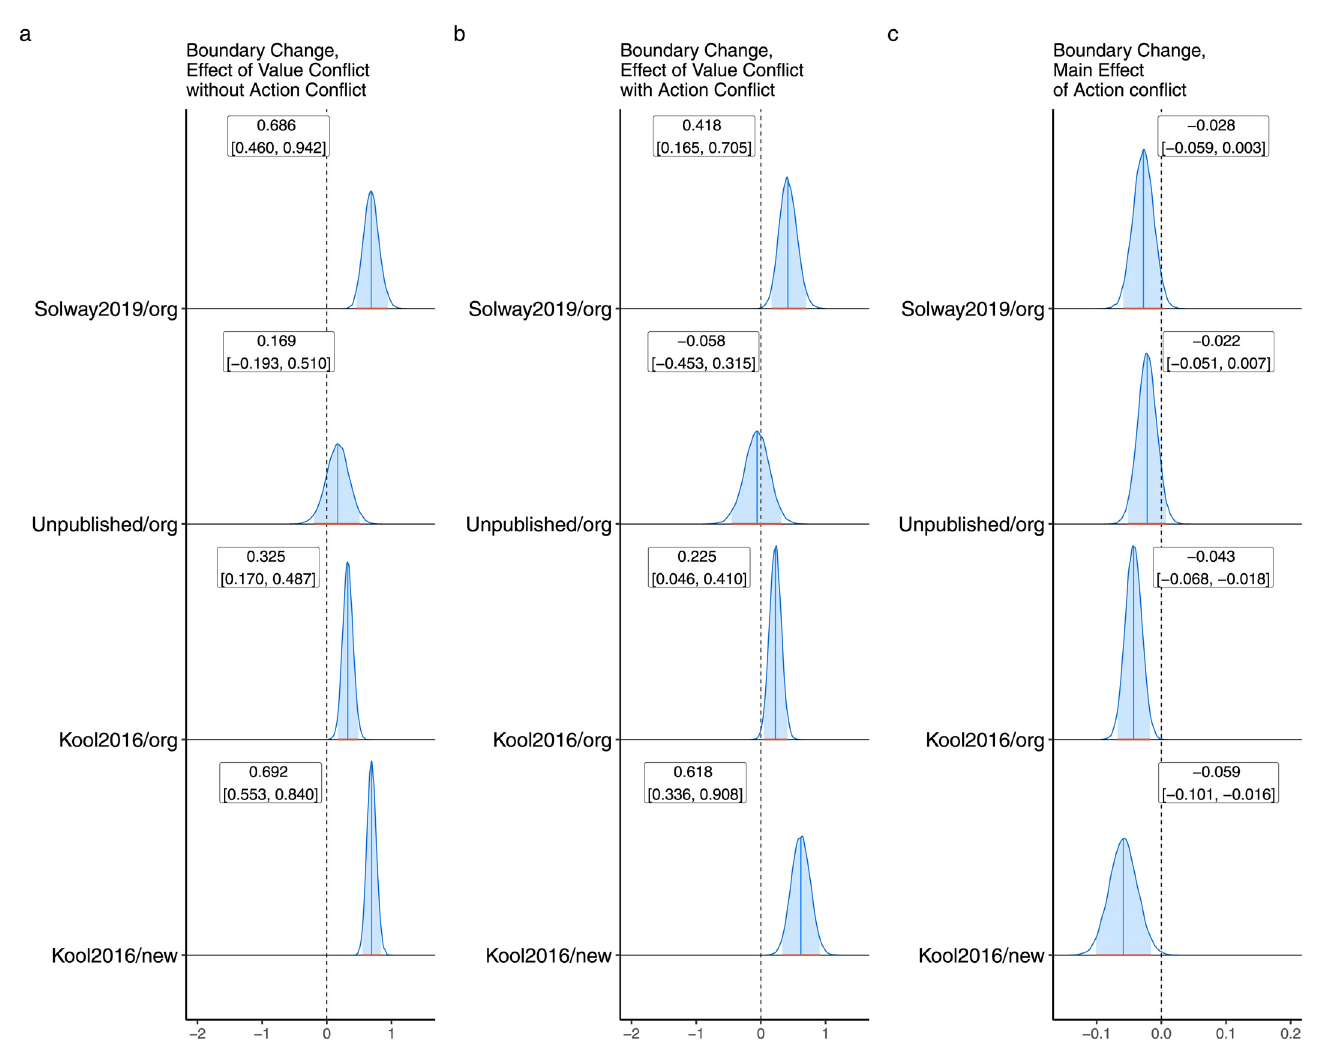
Fig 4. A. The effect of value conflict in the absence of action conflict on decision boundary separation. B. The same as (A), but for trials with action conflict. C. Main effect of action conflict on decision boundary